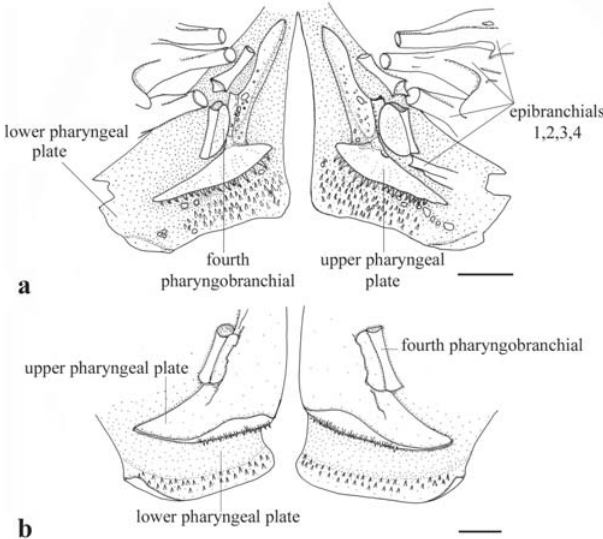
Fig. 25. Dorsal view of posterior portion of branchial arches of Lamontichthys filamentosus (LACM 41741-9, 119.4 mm SL) (a) and Sturisoma sp. (MZUSP 50112, 115.2 mm SL) (b). Cartilages not represented. Scale bar = 1 mm.